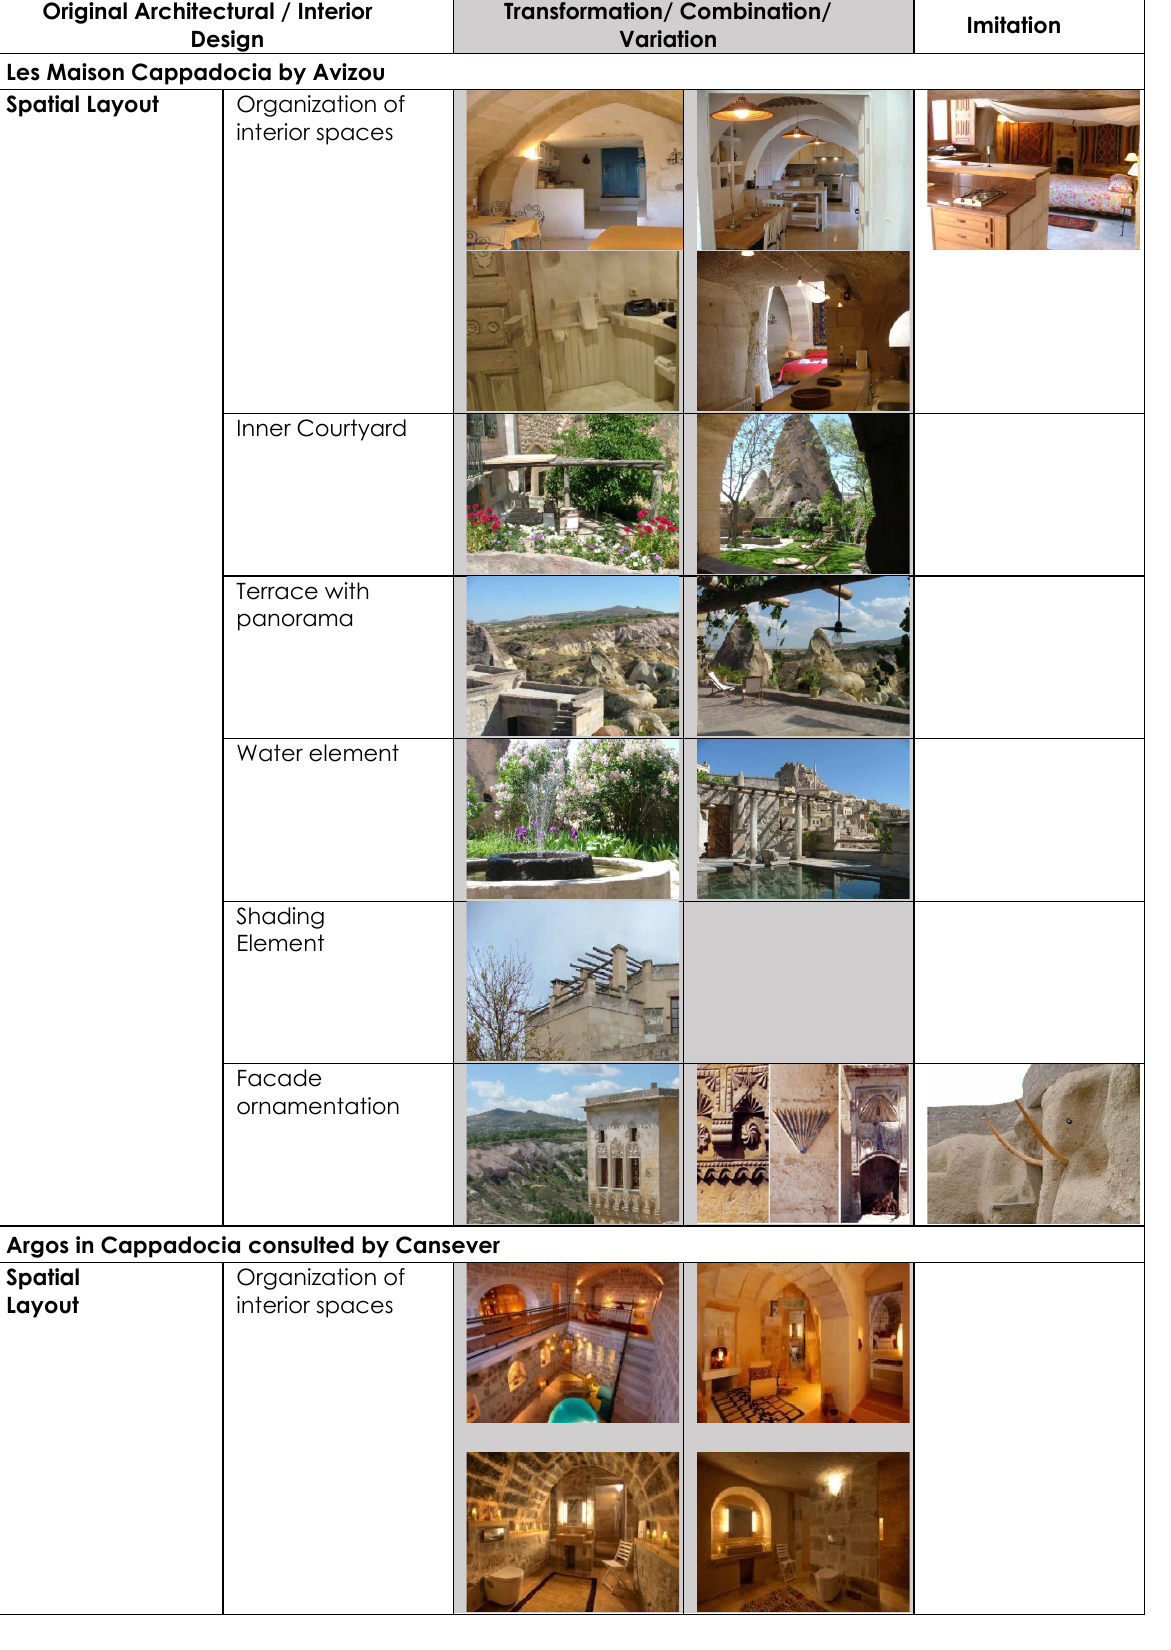
Table 6. Taxonomy of Design Guideline ‘Spatial Layout’ according to Levels of Novelty. (Les Masion Cappadocia., 2019 ; Argos Yapi 2019) Original Architectural /